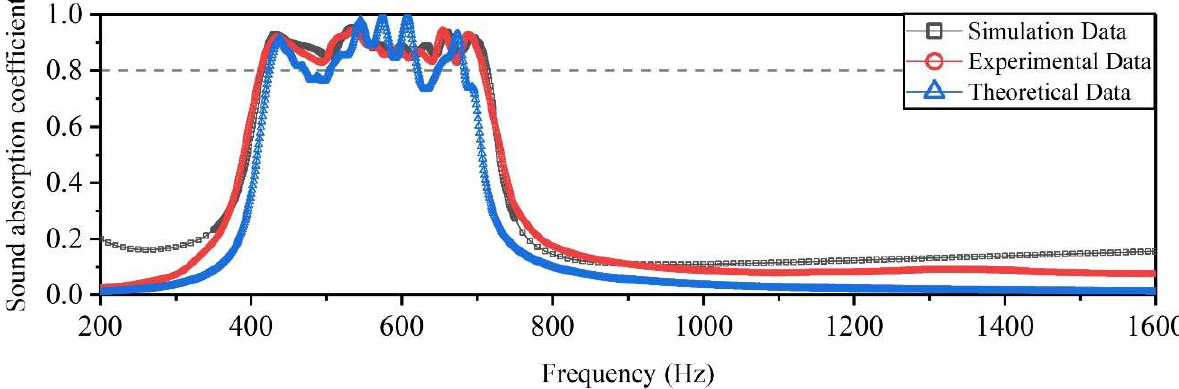
Figure 9. Comparisons of theoretical, simulation and experimental sound absorption coefficients of the proposed acoustic metamaterial of multiple parallel hexagonal Helmholtz resonators.